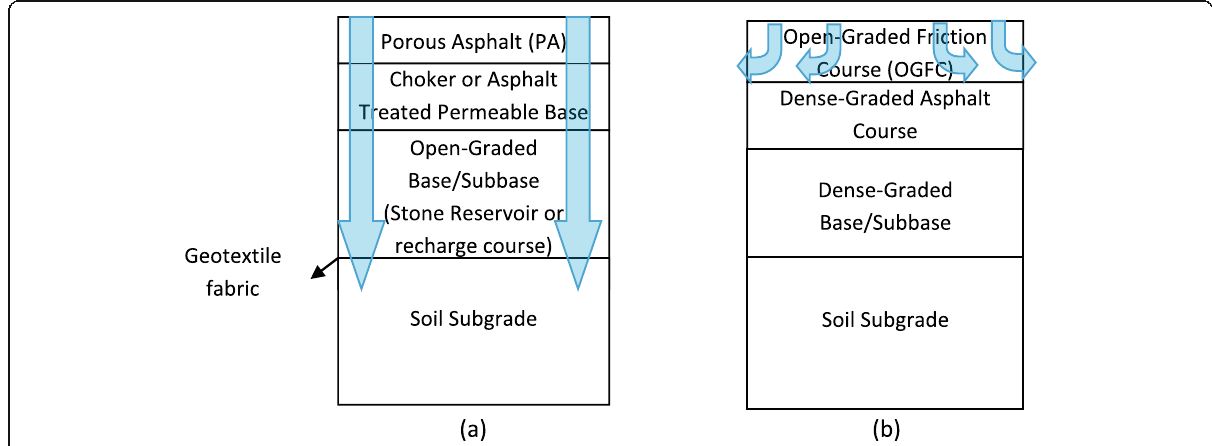
Fig. 1 Typical structures and water flow paths of ( a ) porous asphalt pavement and ( b ) pavement with open-graded friction course. (Layer thicknesses are not